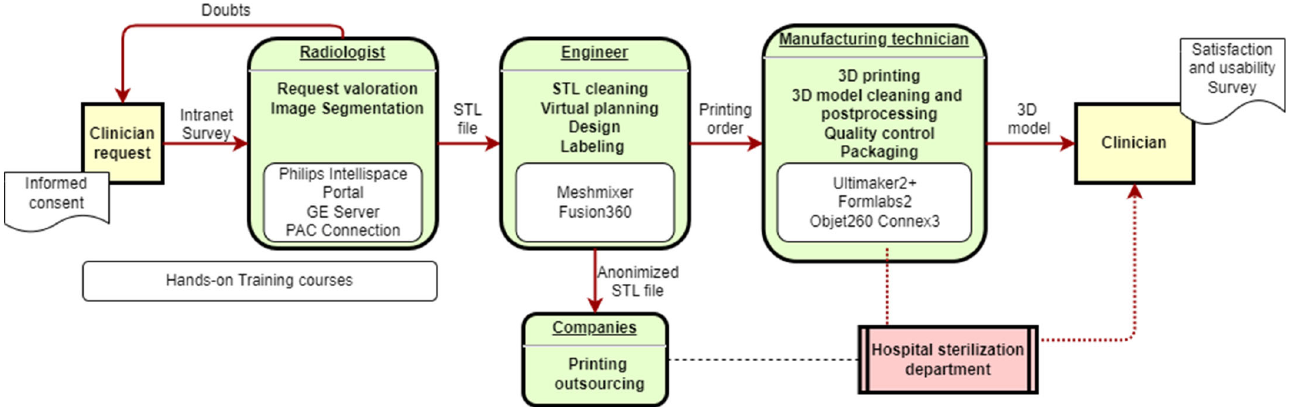
Figure 2. Workflow defined for the 3D printing process at Cruces Hospital. The request is made by the clinician through a form on the intranet. The request is received by the 3D printing team formed by radiologists and engineers, the request is evaluated, and once the CT or MRI image test has been performed, the segmented files are sent in STL format to the engineers who are responsible for de ‐ signing and 3D image processing to ensure its correct printability. The printing, processing, pack ‐ aging and quality control of the model is performed by the manufacturing technician. In the case of operating room use, the model is sent to the sterilization